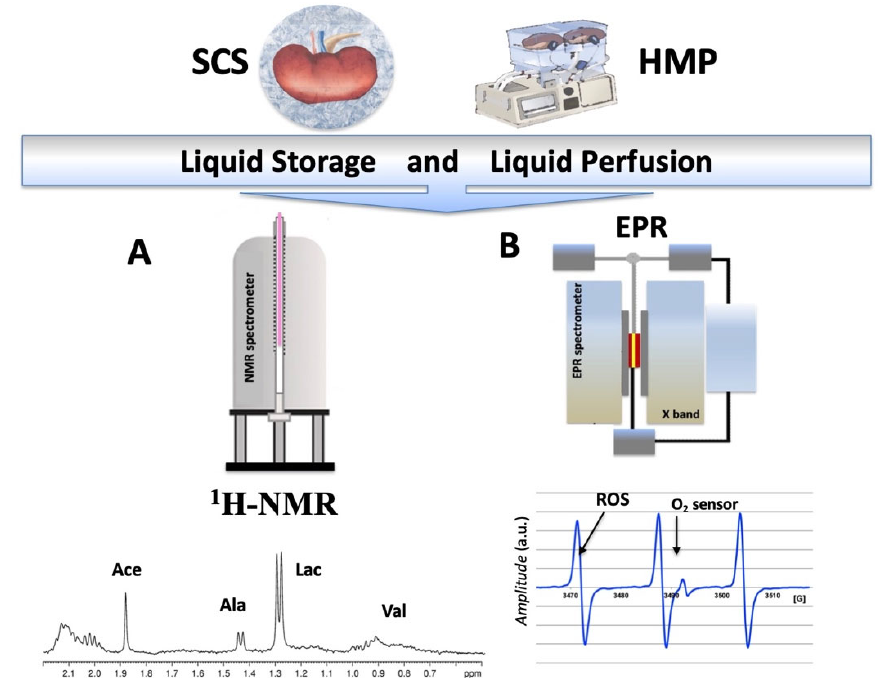
Figure 1. Static cold storage (SCS, the kidney stored in solution surrounded by crushed ice to keep the temperature between 4 and 0 ◦ C is shown in the photo) and hypothermic machine perfusion (HMP, the kidneys in the machine are shown in the photo) preservation conditions assessed by NMR ( A ) and EPR ( B ) instruments. Under the instruments: (left) a typical high field 1 HNMR spectrum obtained from the perfusion solution during a SCS or HMP experiment. The main assigned resonances are indicated by arrows: Valine: proximal tubules disfunction; Lactate: global ischemia; Acetate: cortical lesion; and TMAO: medullar lesion. Right: a typical EPR spectrum recorded from the perfusion solution at 37 ◦ C. The triplet signal comes from the reaction of 1-hydroxy-3-carboxymethyl-2,2,5,5-tetramethyl- pyrrolidine spin probe (CMH, EPR silent) to 3-carboxymethyl-2,2,5,5-tetramethyl-pyrrolidinyloxy radical (CM, EPR active). When the signal is sequentially acquired, the ROS production rate can be calculated. Using a stable radical compound, such as 3-Carboxy-2,2,5,5-tetramethyl-1-pyrrolidinyloxy (CP), as a reference, the absolute concentration levels are obtained. The singlet is the signal from oxygen label (O 2